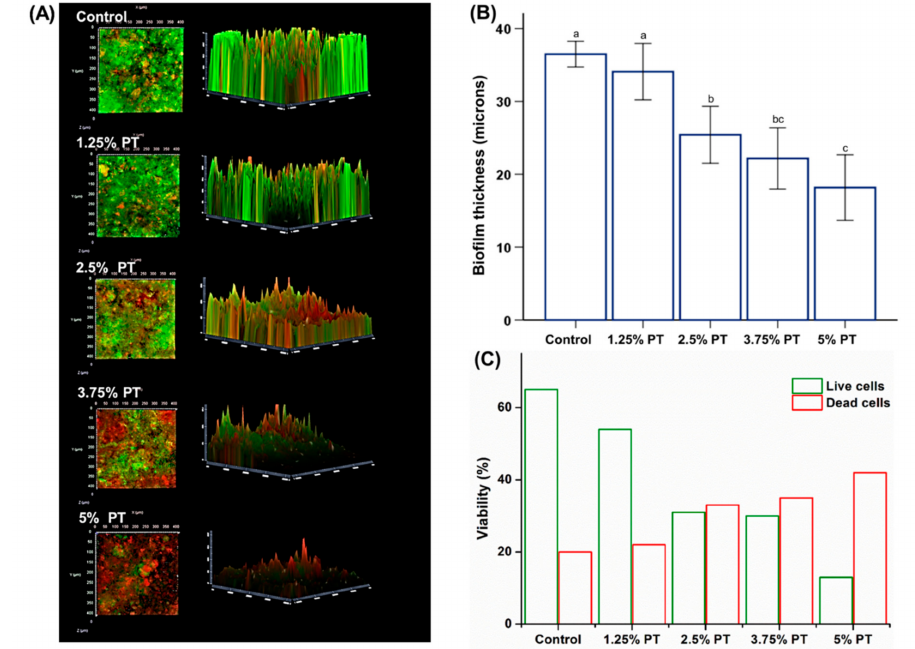
Figure 6. Representative saliva-derived biofilm accumulation images of C. albicans attached on the surfaces of PMMA samples; control, 1.25% PT, 2.5% PT, 3.75% PT and 5% PT at a magnification of 5000 × ( A ), Biofilm thickness derived from fungi attached on the surfaces of PMMA samples ( B ), Live–Dead assay quantified as the live and dead cells in equivalent surface areas ( C ). Same lowercase alphabetical letters above the bar graph indicate that there are no significant di ff erences between the groups (e.g., there are no di ff erences between the group with ‘a’ and another group with ‘a’ above the bar) ( p > 0.05). Di ff erences in lowercase alphabetical letters above the bar graph indicate significant di ff erences between the groups (e.g., there are di ff erences between the group with ‘a’ and the group with ‘b’.) ( p <